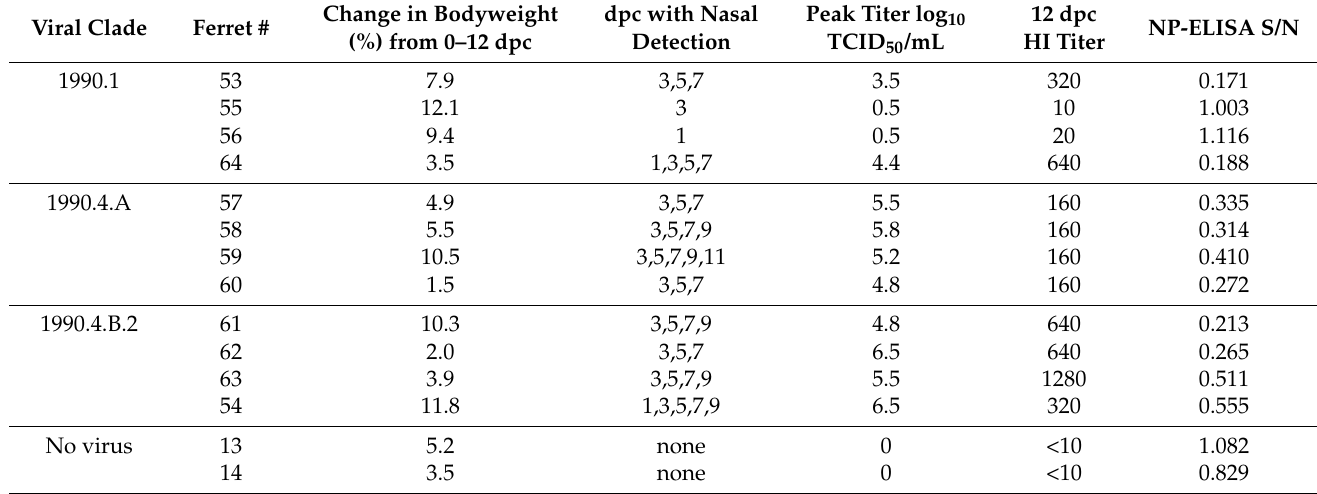
Table 3. Cumulative clinical, viral, and serological measures of ferrets exposed to H3N2-infected pigs.